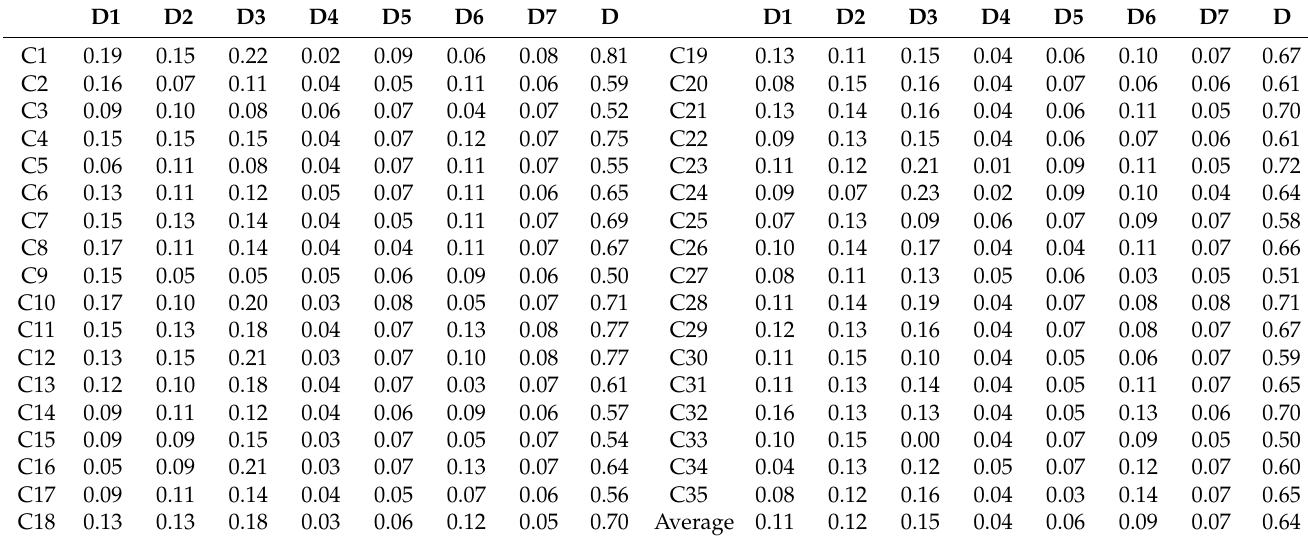
Table 6. The value of quantitative UPSCC performance value for the sample